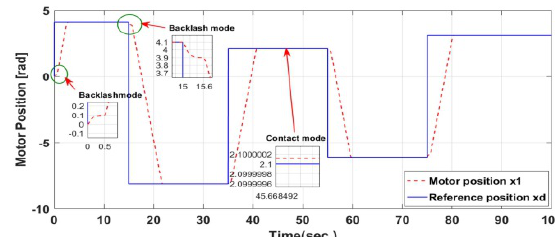
Figure 10. Reference position x d , motor position ( x 1 = θ m ), and load position ( x 3 = θ l ) vs. time for the two-mass system connected by a gearbox